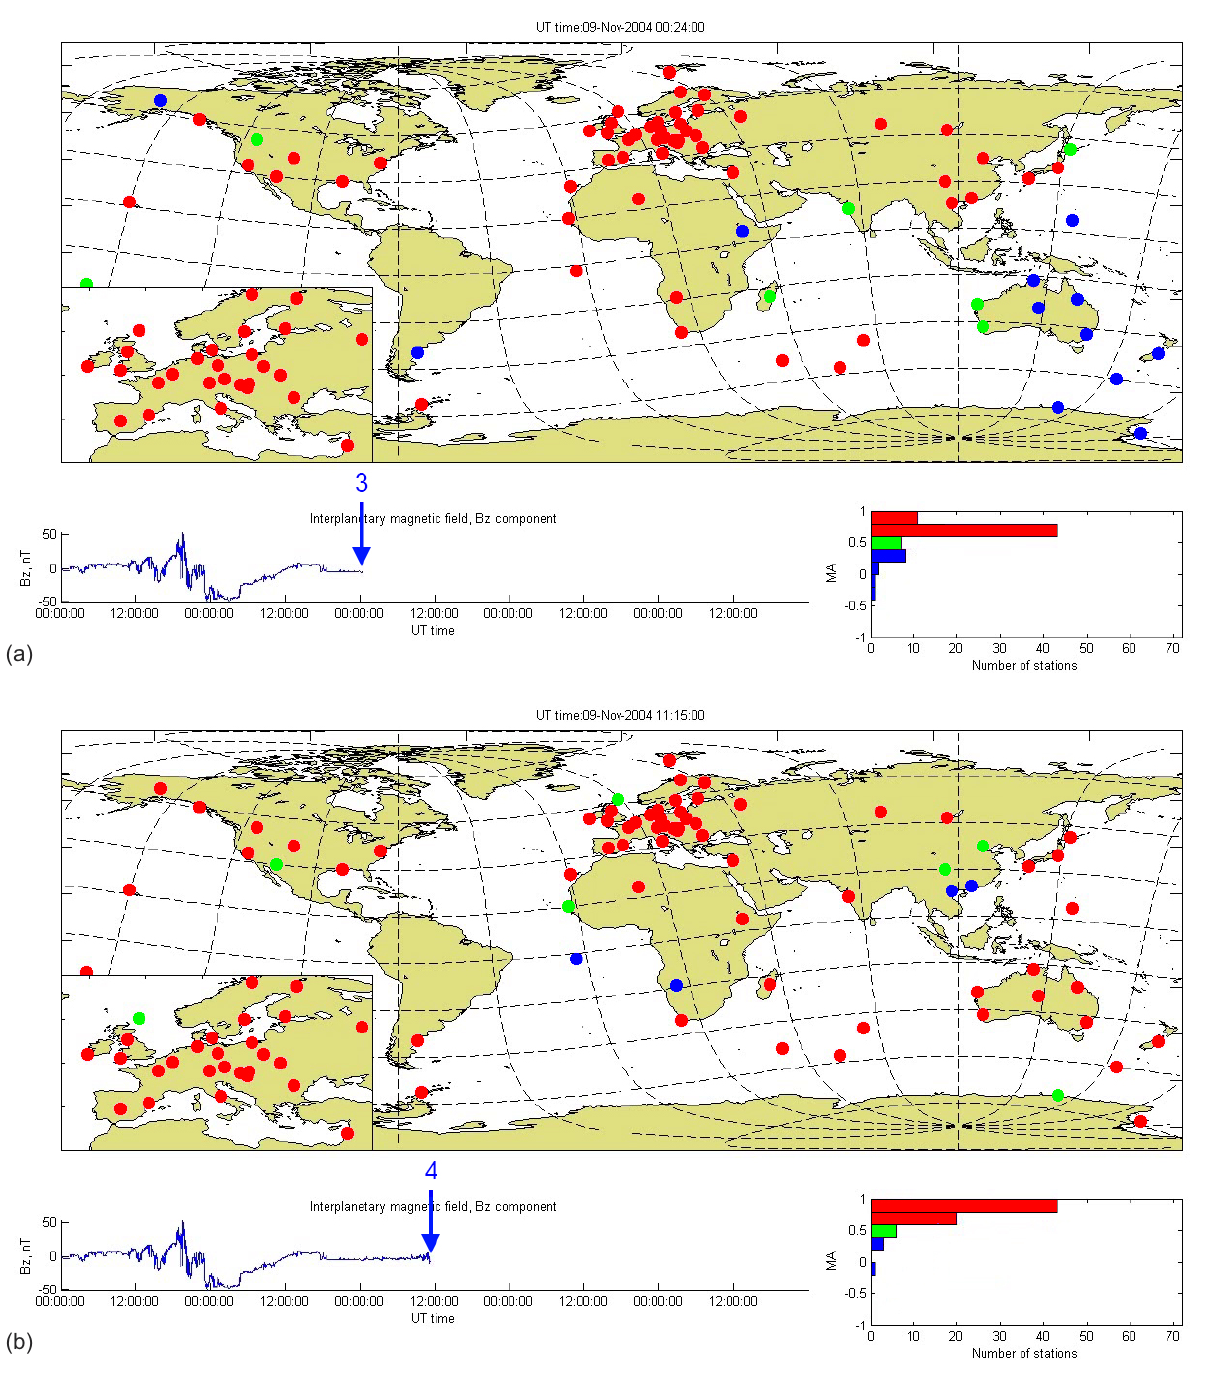
Figure 10. An example of the GIS-based software operation for global monitoring of MA, calculated using H component, over the globe. Dynamic histogram with MA value distribution depending on the number of observatories is given below on the right and dynamic plot with IMF Bz component is given below on the left. These two snapshots were taken at times 3 (a) and 4 (b) marked with blue arrow (simi- lar snapshots are available at times 1 and